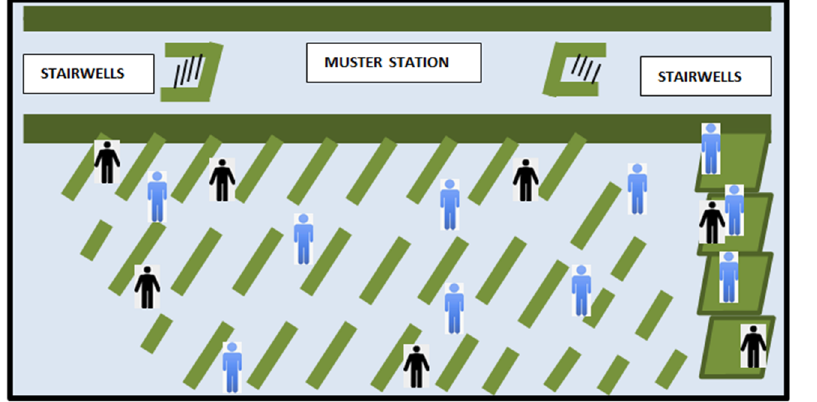
Figure 1. MVZs Layout Example.